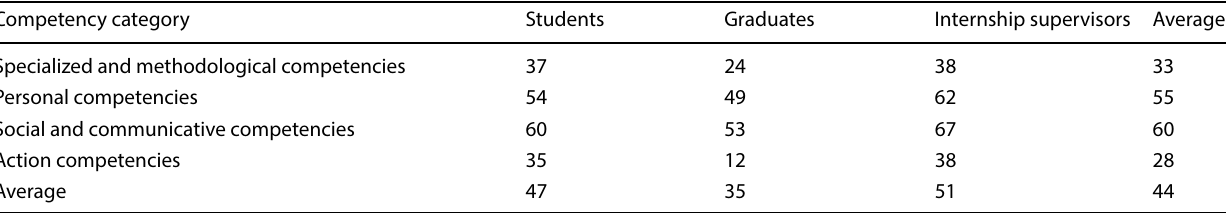
Table 3 Average regarding the assessment of the importance of the competencies with regard to the intended professional activity (stu- dents), the importance for the current professional activity (graduates) and for the professional field of the internship supervisors (per com- petency category as "very important" in